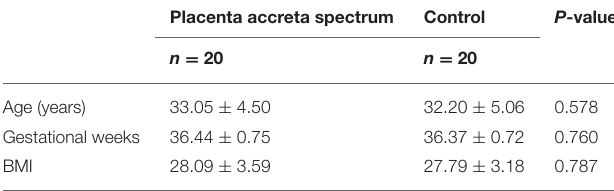
Frontiers in Molecular Biosciences |